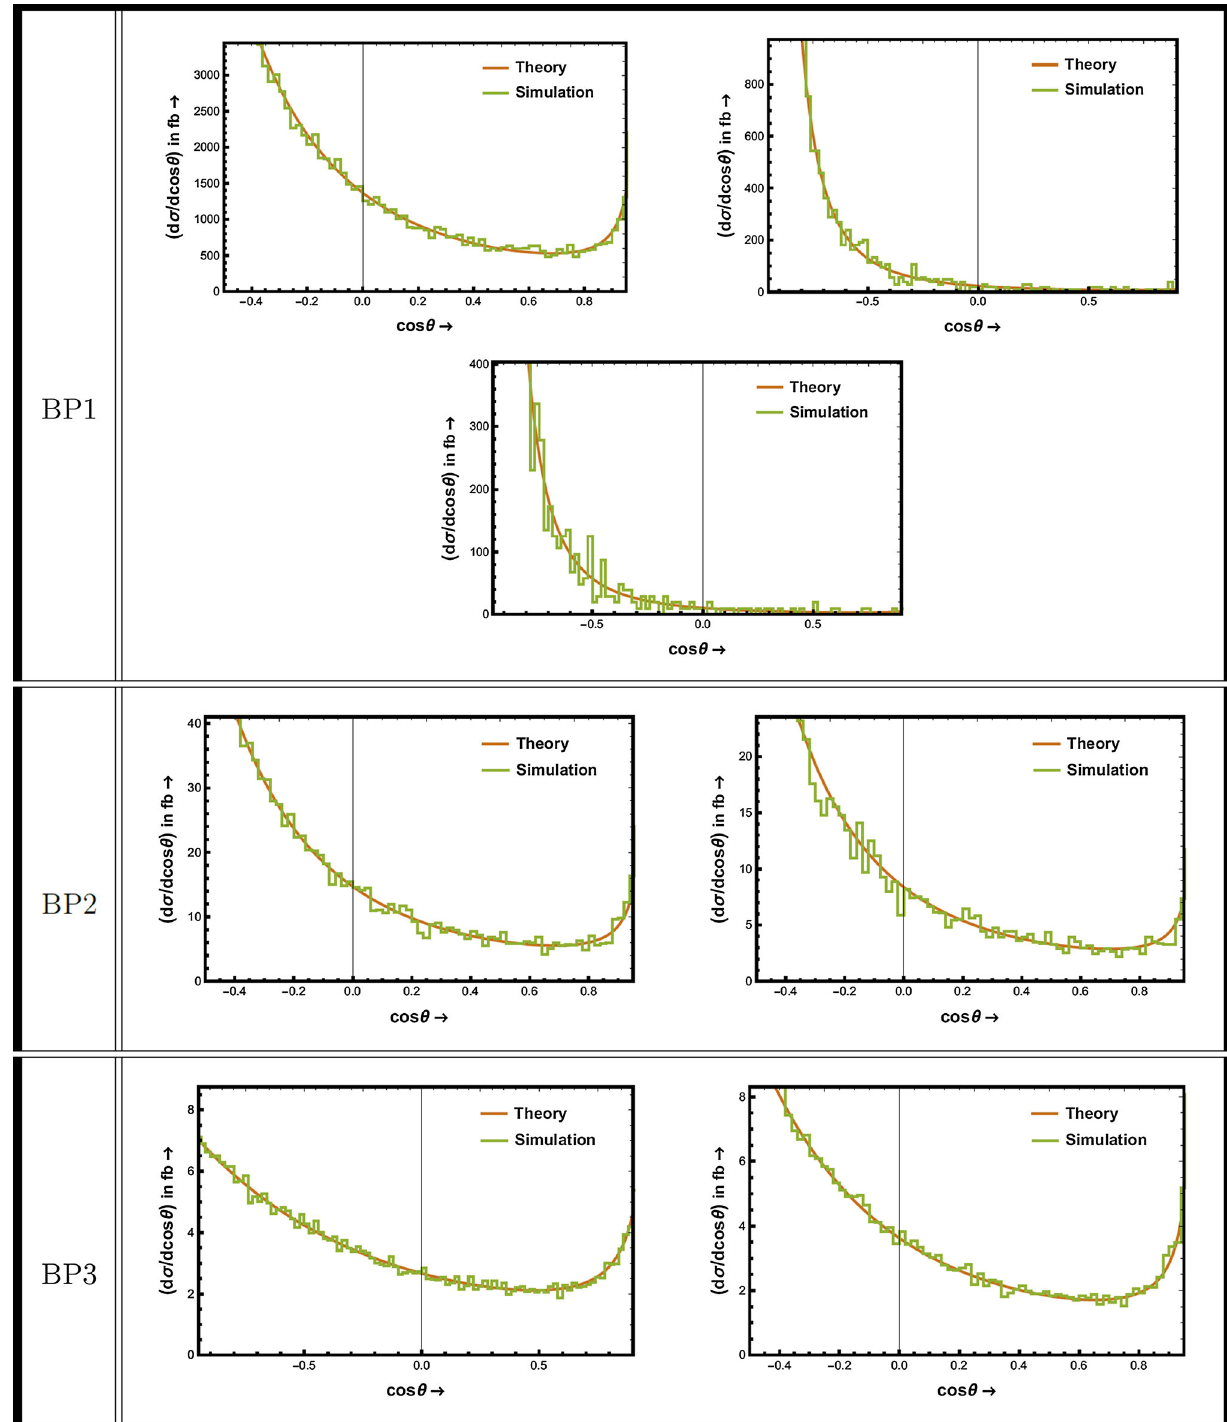
/ 3 ) c at various center of momentum energies for different benchmark points, arranged in Fig. 11 Angular distribution for the production of ( V + 4 2 μ the order of Table 11. The brown (smooth) and green (jagged) lines indicate the theoretical expectations the PYTHIA simulated